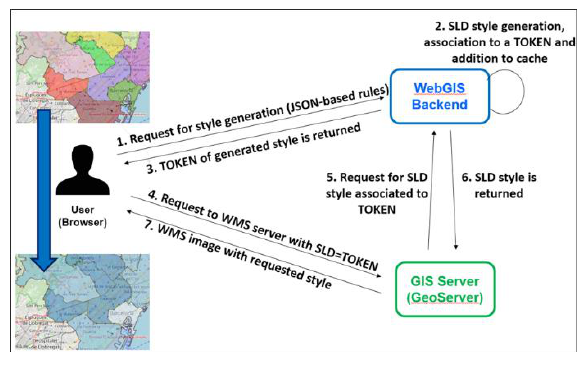
Figure 14. WMS Dynamic Thematization